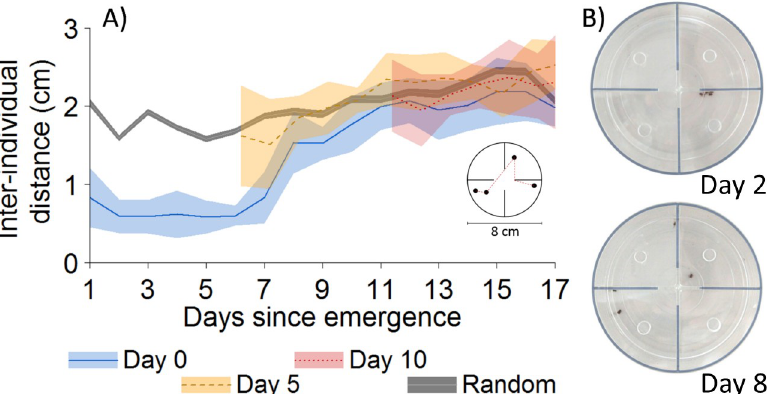
Fig 1. Dynamics of dispersal in spiderlings of A . labyrinthica . A) Mean interindividual distance as a function of days in groups of four spiderlings introduced to an experimental arena immediately upon emergence (blue, N = 10) or five days (yellow, N = 10) and 10 days (red, N = 9) after emergence. The grey line represents the interindividual distance expected under a random distribution of four individuals. Colored bands are 95% CI. Inset: Spiderlings were introduced in a circular arena partitioned into four compartments. For groups, we computed the interindividual distance as the shortest distance to connect all four individuals (red dotted line). B) Photos representing the spatial distribution of spiderlings in the experimental arena before (Day 2) and after dispersal (Day 8). The inner and outer walls of the arena are highlighted in dark blue on the photos for illustrative purposes. Relevant data values are included in S1